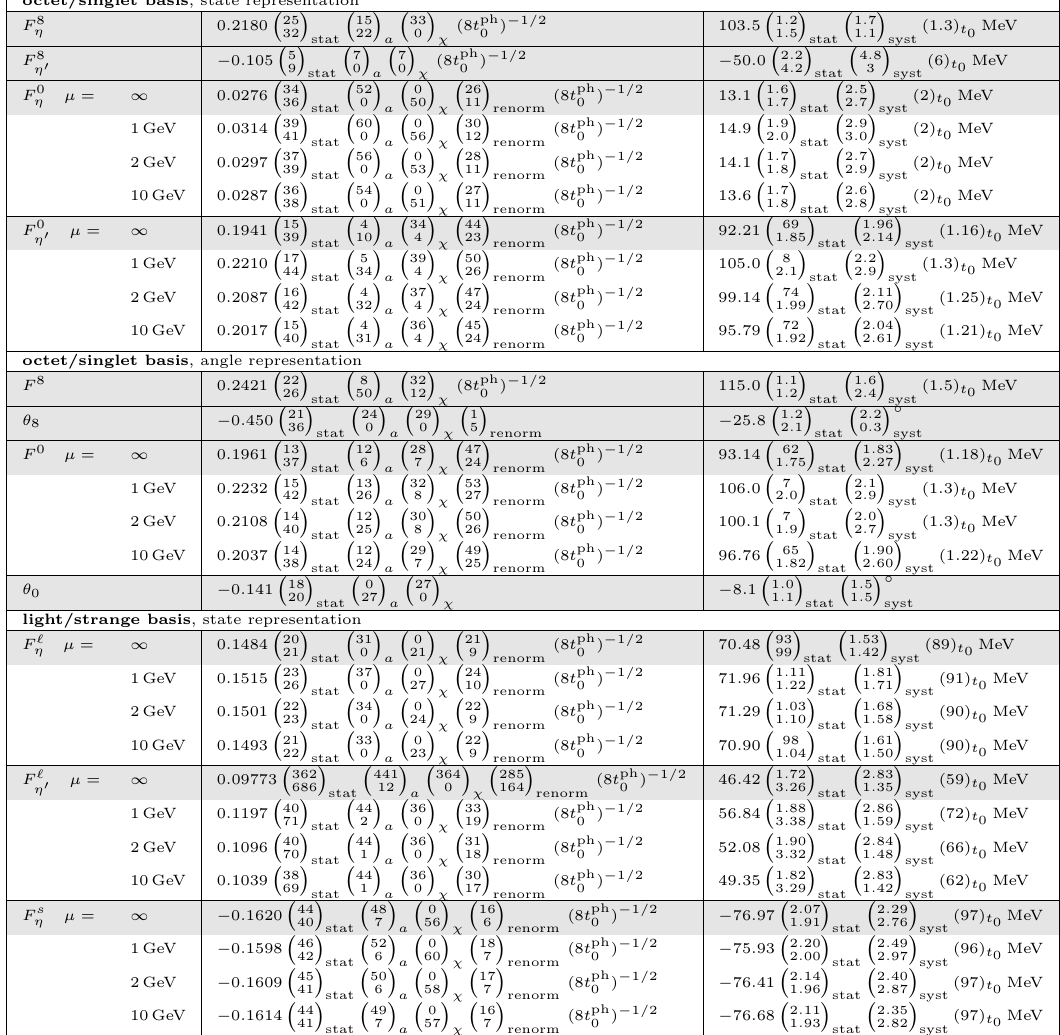
Table 25. Decay constants, using the experimental η and η 0 masses as additional input (priors, see section 5.7) in various representations and at several renormalization